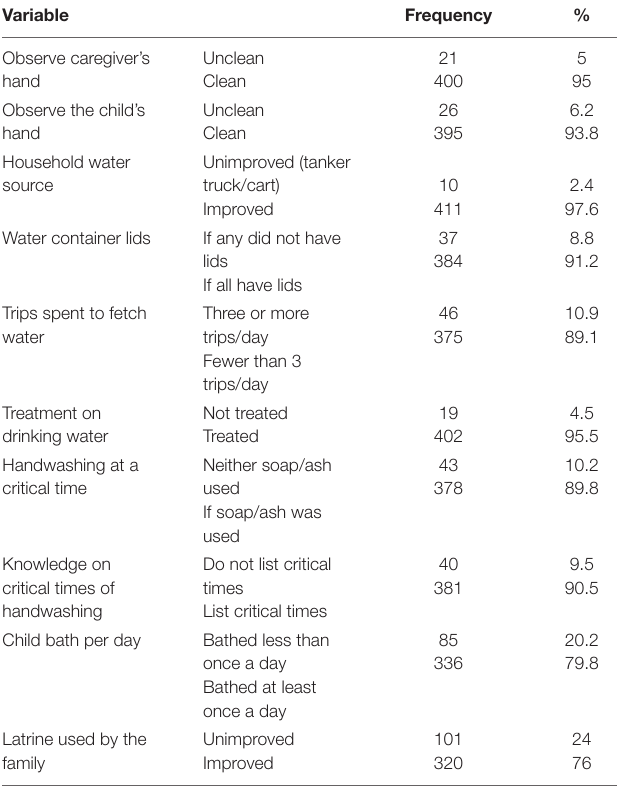
TABLE 6 | Family water and sanitation characteristics, Dessie Town, South Wollo Zone, Northeastern Ethiopia, 2021. Variable Frequency